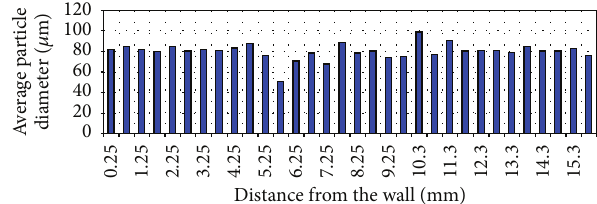
Figure 14: Distribution of the average particle diameter of the two- side reinforced